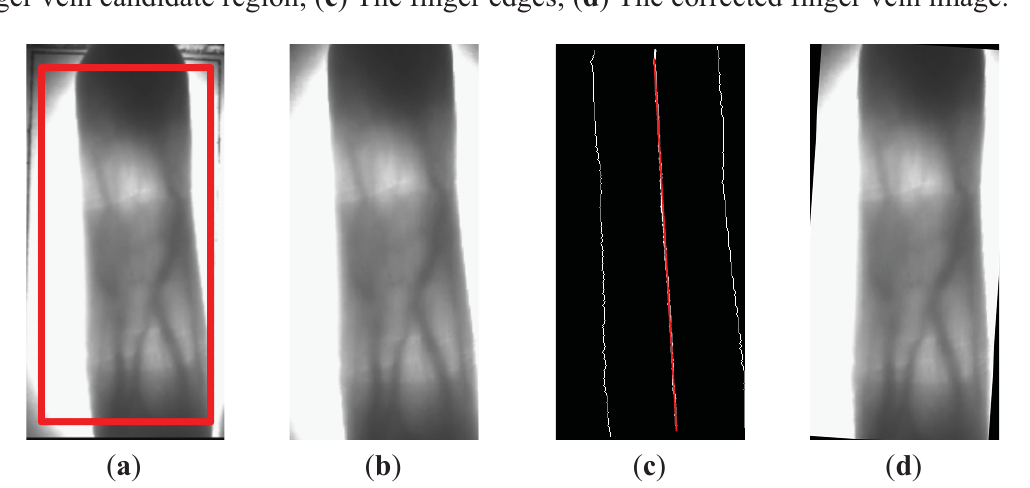
Figure 2. Skew image detection and correction. ( a ) A predefined window in red; ( b ) The finger vein candidate region; ( c ) The finger edges; ( d ) The corrected finger vein